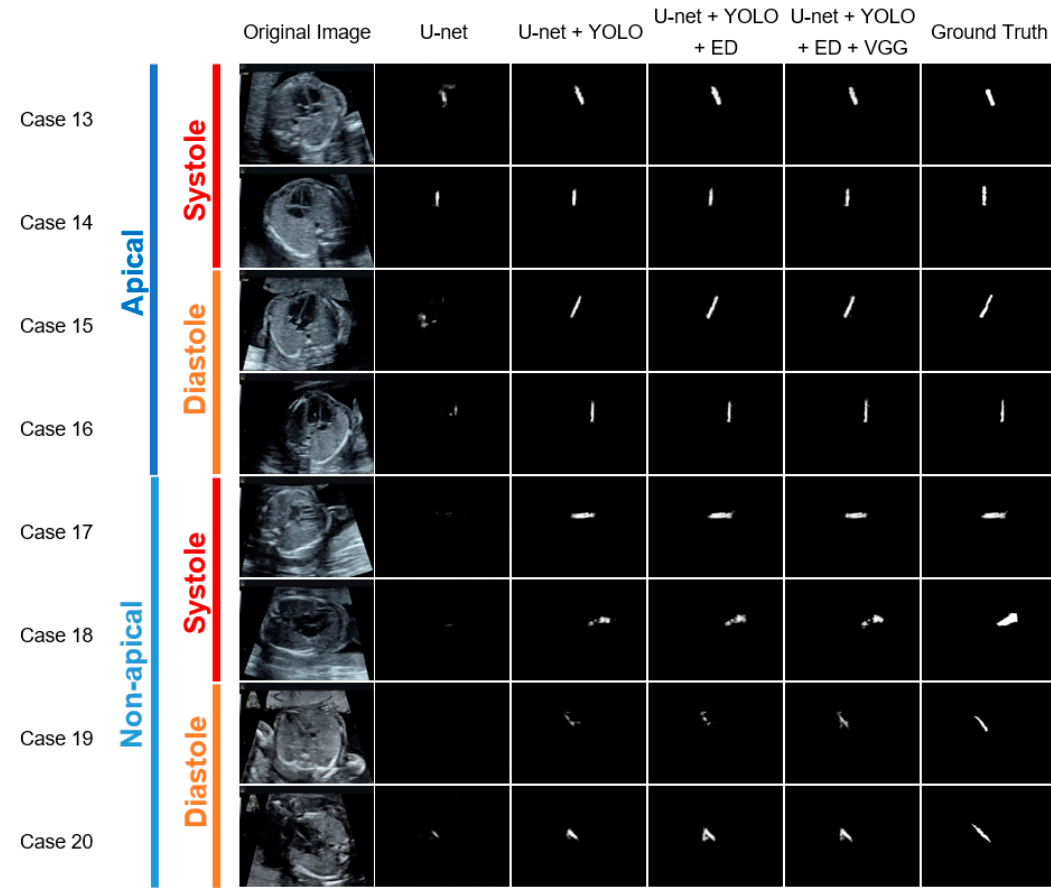
Figure 5. Representative examples of the ventricular septum segmentation images classified by the cardiac axis orientation and ventricular systolic state, from the test data, for each module combination. One horizontal row presents the segmentation results obtained using each method for the same case. The white pixels are estimated as the ventricular septum, and the whiteness indicates the confidence level. The segmentation results were more accurate for the apical group than for the non-apical group, and more accurate for the diastolic group than for the systolic group, irrespective of the module combination. The addition of the YOLO significantly improved the segmentation accuracy, and the addition of the ED further improved it, irrespective of cardiac axis orientation and ventricular systolic state. Moreover, the addition of VGG slightly improved the segmentation accuracy for the systolic and non-apical groups.